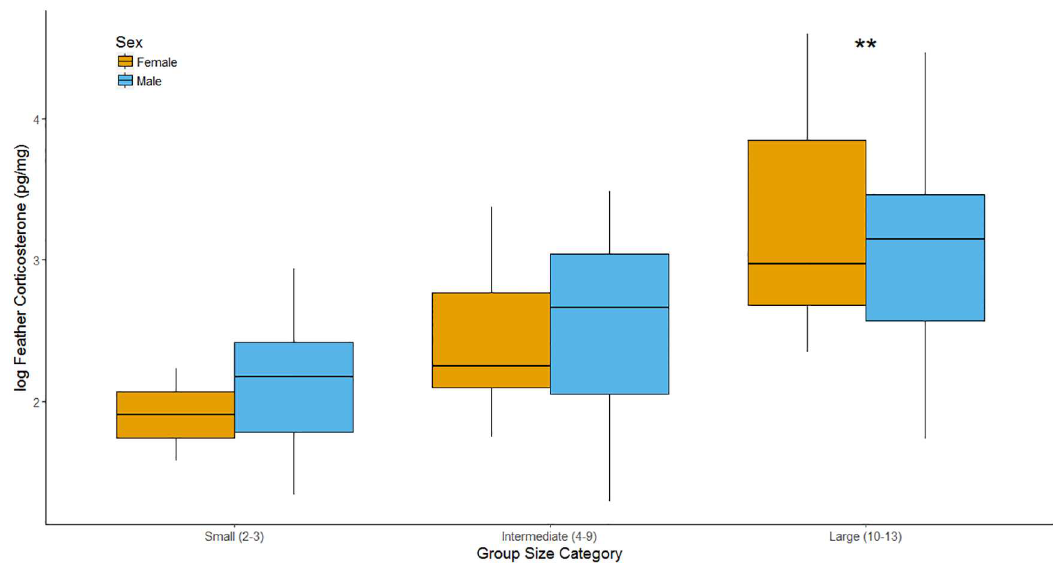
Fig 1. Log transformedfeather corticosterone (pg/mg) of adult Smooth-billed Anis ( Crotophaga ani ) according to categorical social group size. Categorical group sizes determined by deviationfrom the mean ( x ( ± SD). Yellowbars represent females and blue bars represent males. Medianconcentrations of corticosterone are shown with horizontal dark lines in boxes. Whiskers represent ± 1.5 times the interquartile range (distancefrom the fist to third quartile).